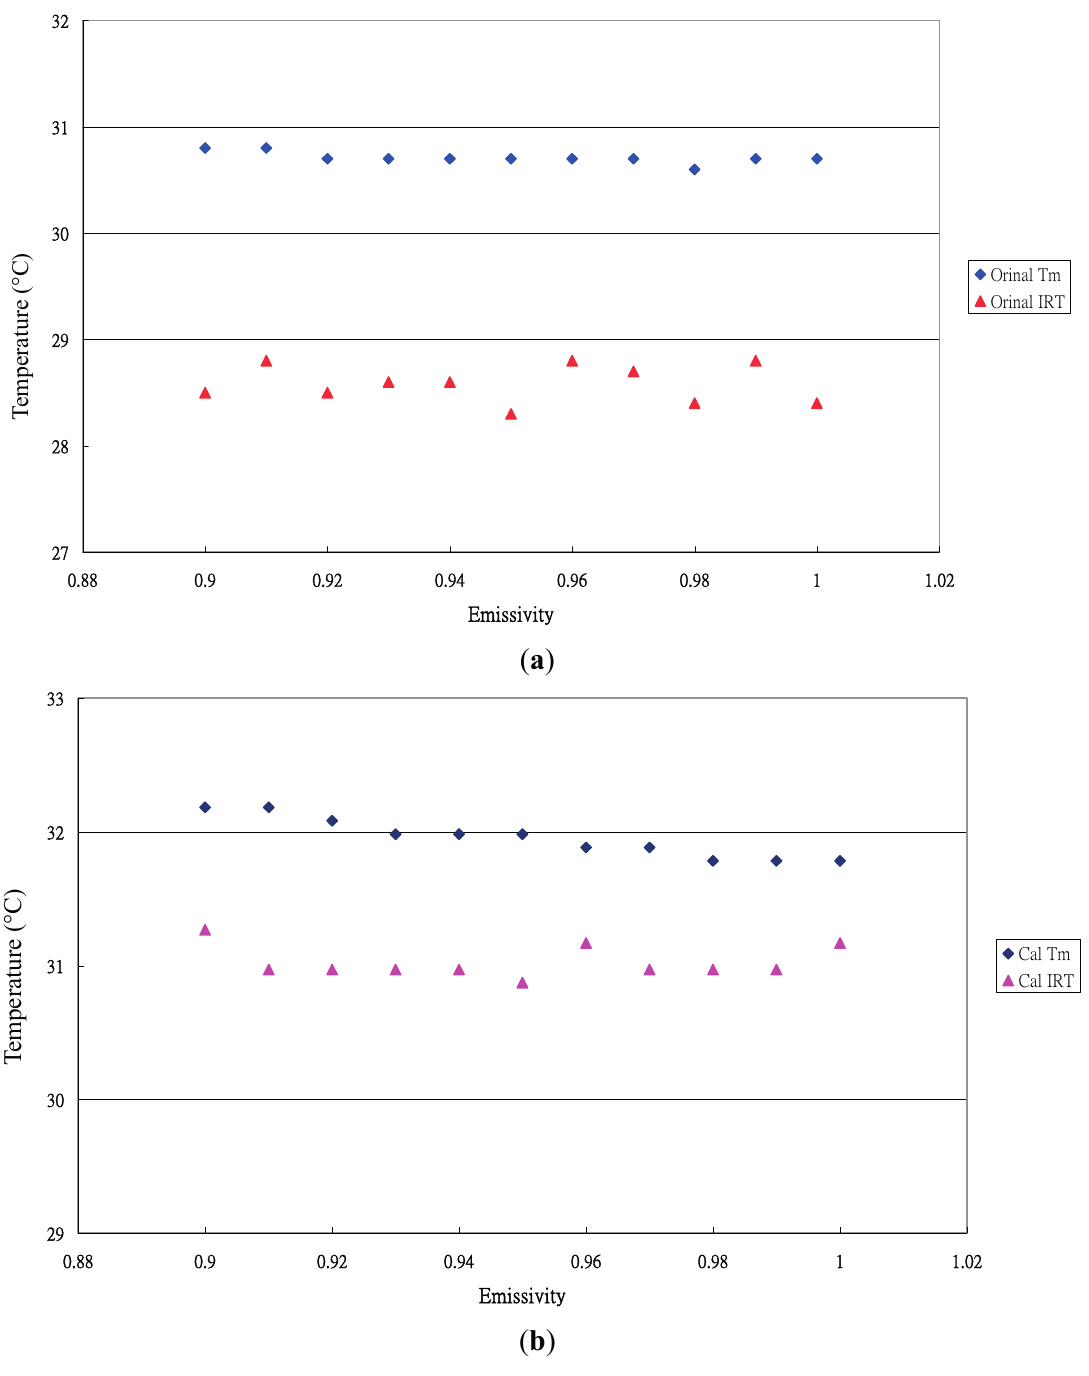
Figure 1. Typical distribution of the original and transformed measured data for Phalaenopsis leaves. ( a ) Original temperature data; ( b ) Transformed data. ε value is shown in Figure The data distribution for the ratio and is